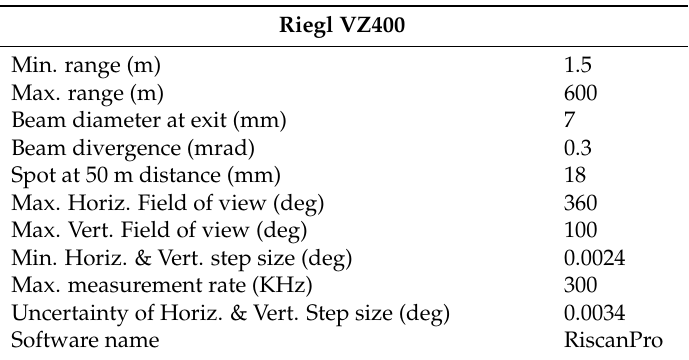
Table 1. A few characteristics of the TLS used.